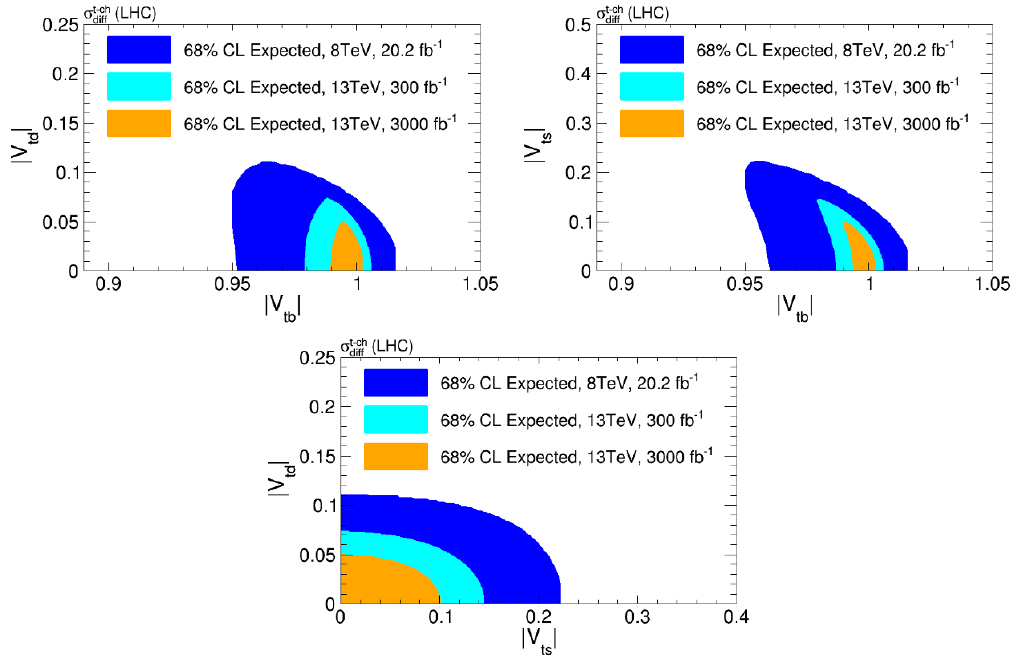
Figure 8 . Comparison of the expected 68% con(cid:12)dence level regions in the ( j V td j , j V ts j ), ( j V tb j , j V ts j ) and ( j V td j , j V tb j ) planes obtained using 8 TeV single top di(cid:11)erential cross section measurements and 68% con(cid:12)dence level regions expected for 300 fb (cid:0) 1 and 3000 fb (cid:0) 1 of data at 13